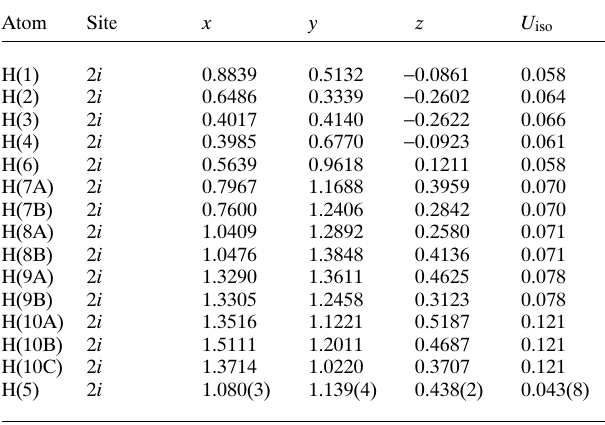
Table 2. Atomic coordinates and displacement parameters (in Å 2 )